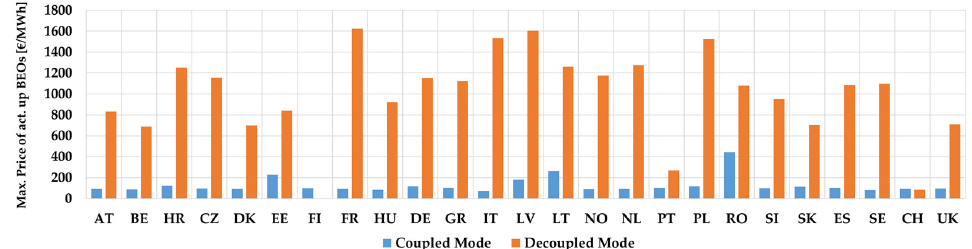
Figure 11. Maximum price of activated upward BEOs in each participating control area.